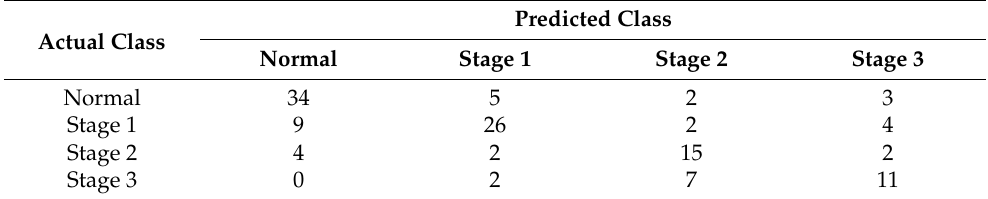
Table 8. Confusion matrix of fluorosis classification on 128 blind test